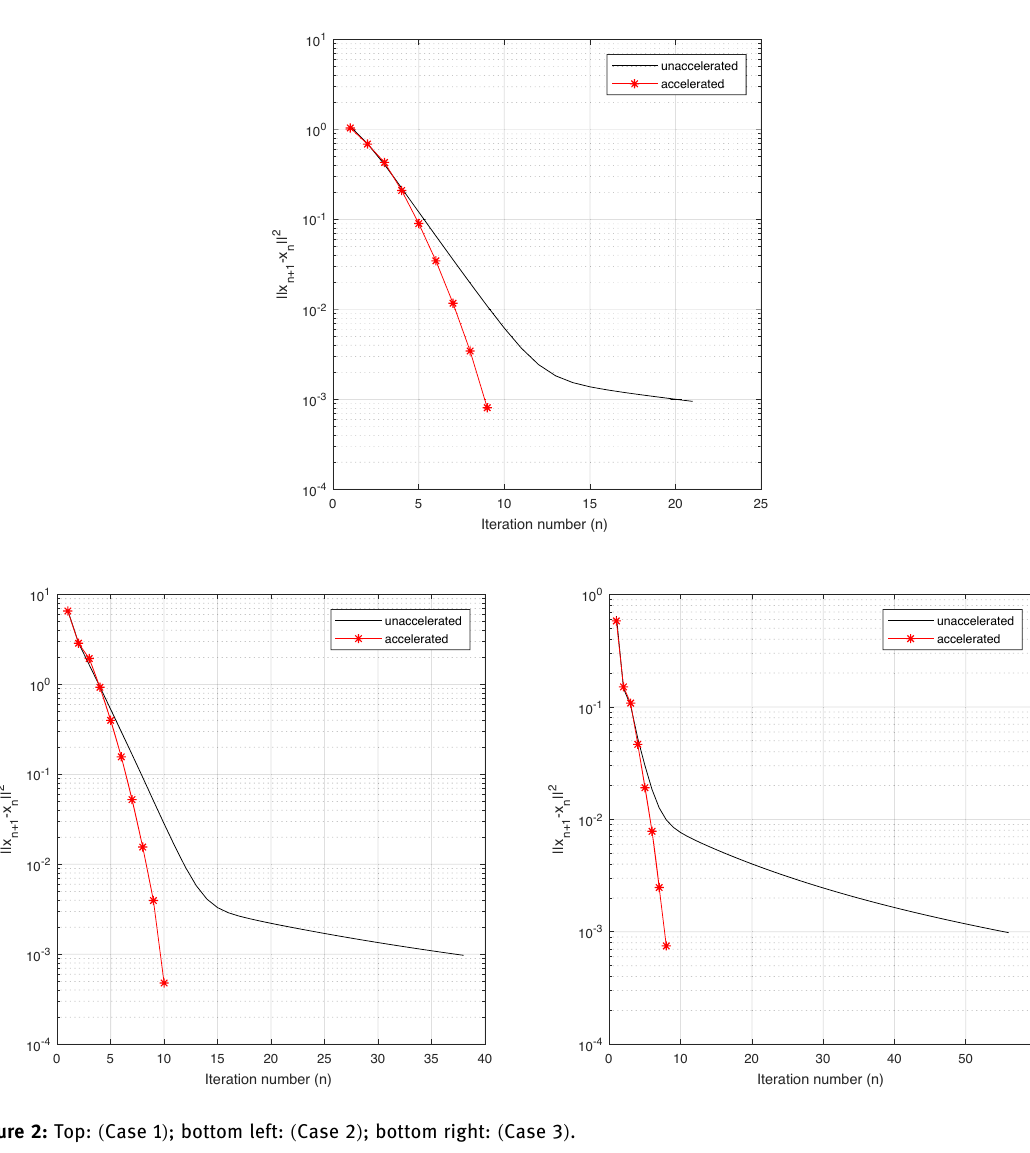
Figure 2: Top: ( Case 1 ) ; bottom left: ( Case 2 ) ; bottom right: ( Case 3 )